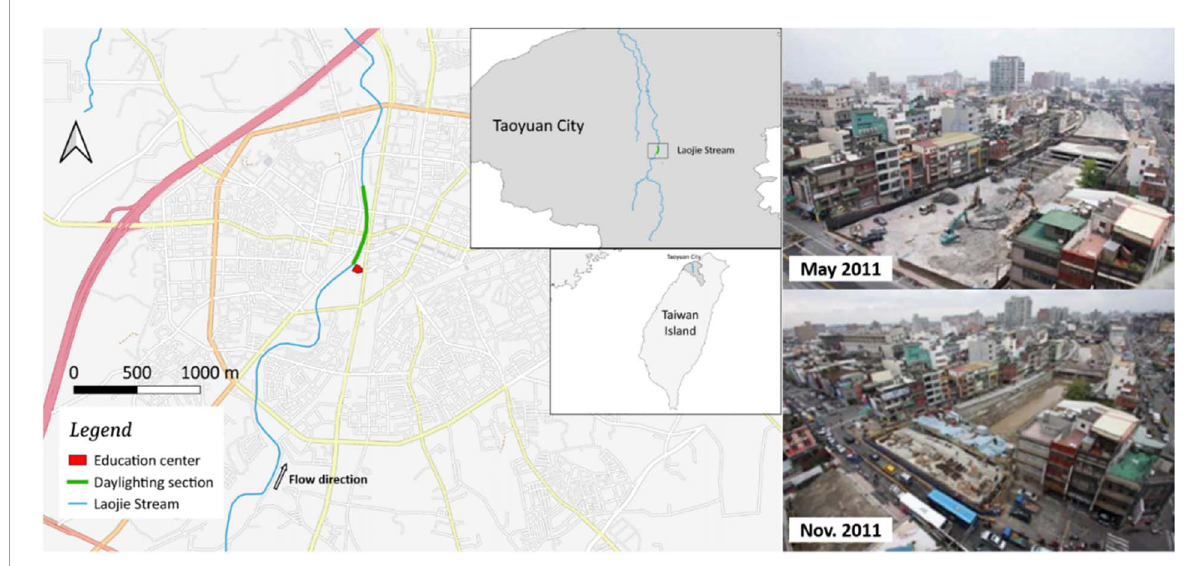
FIGURE14 (Left) Map showing the daylighting section of the Laojie Stream. Map by Chaozhong Tan. (Right) Photographs showing the Laojie Stream before (above) and after the daylighting (below). Photographs from https://www.wra.gov.tw/News_Content.aspx?n=25153&s=88373. ©Taoyuan Department of Water.